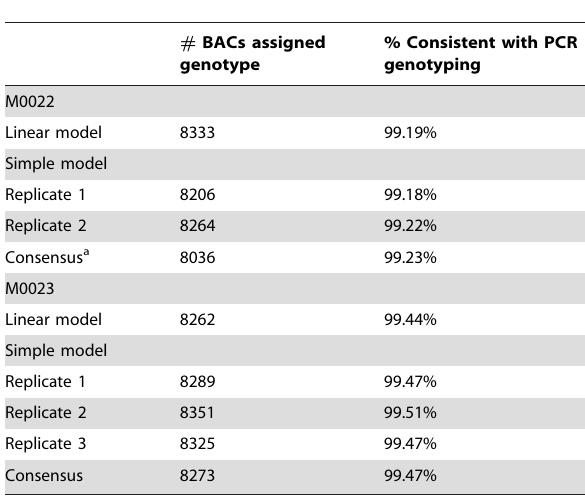
Table 2. Genotyping calls by BAC (Method